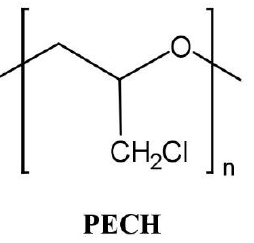
Figure 5. Monomer of poly(epichlorohydrin) — PECH. Table 2. LSER coefficients of poly(epichlorohydrin) (PECH) determined at temperature of 25 ◦